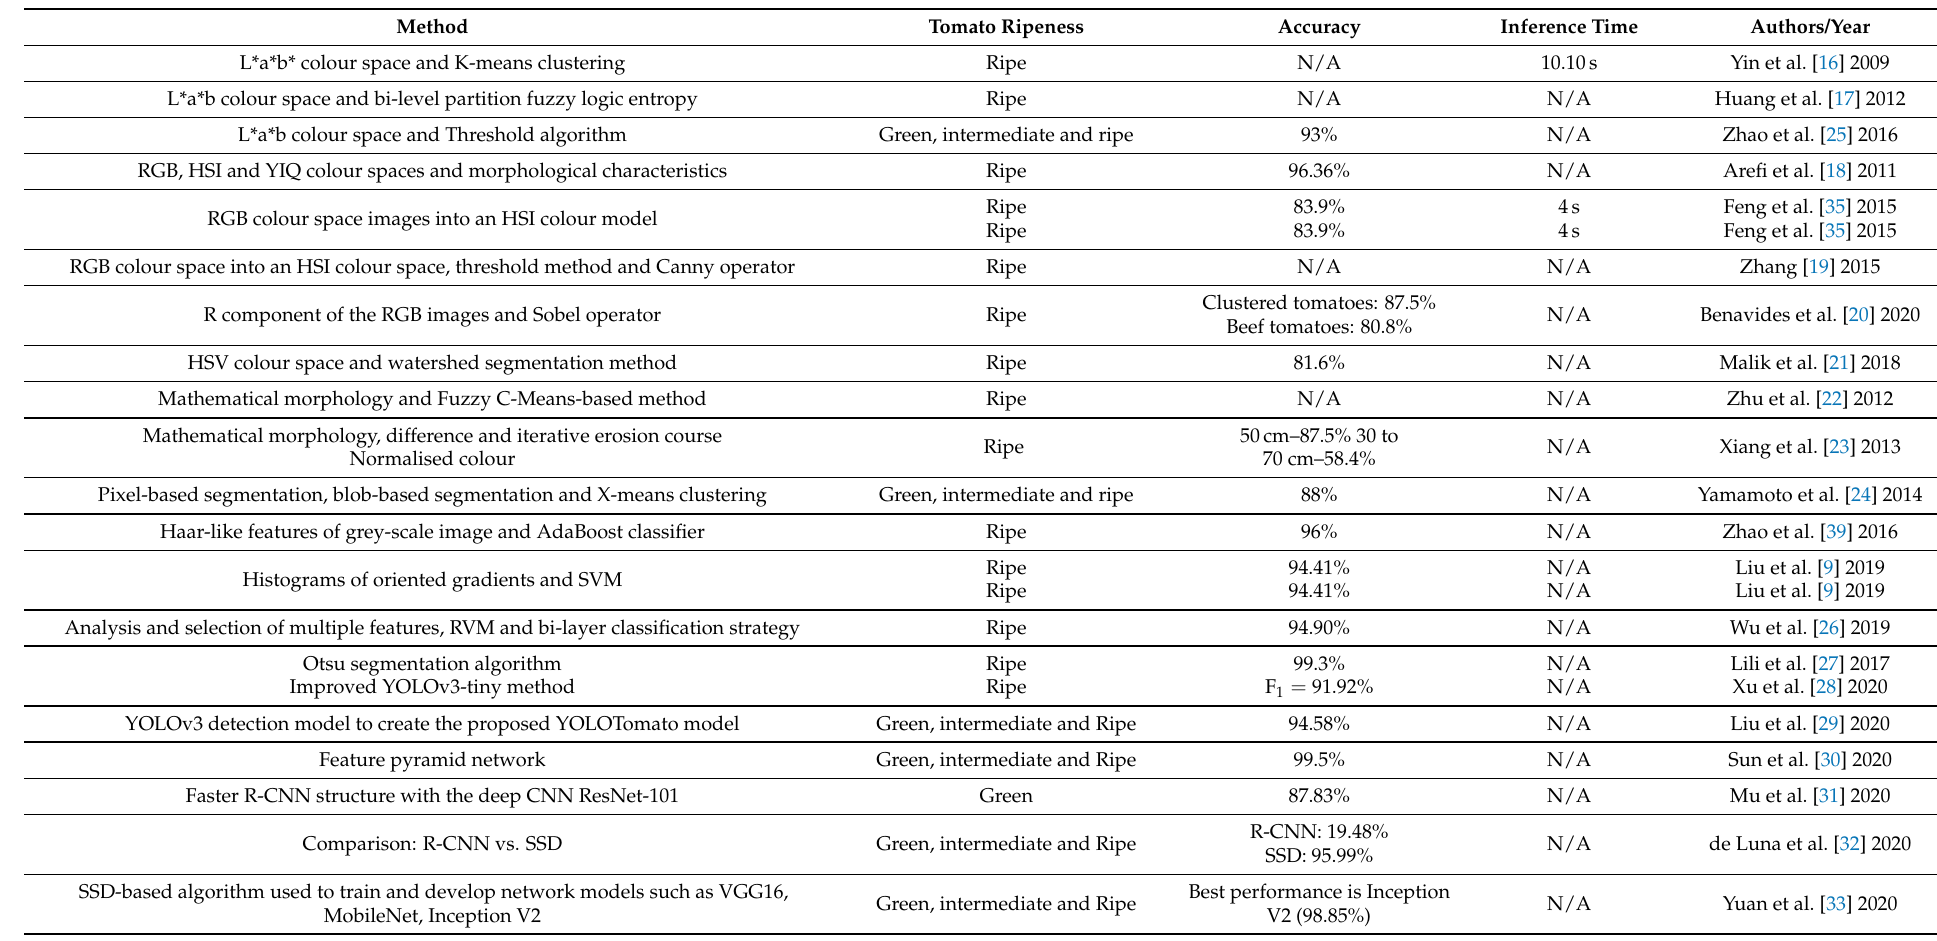
Table 1. Algorithms, methods and techniques proposed by different authors regarding tomato detection at different ripeness levels (N/A—Not